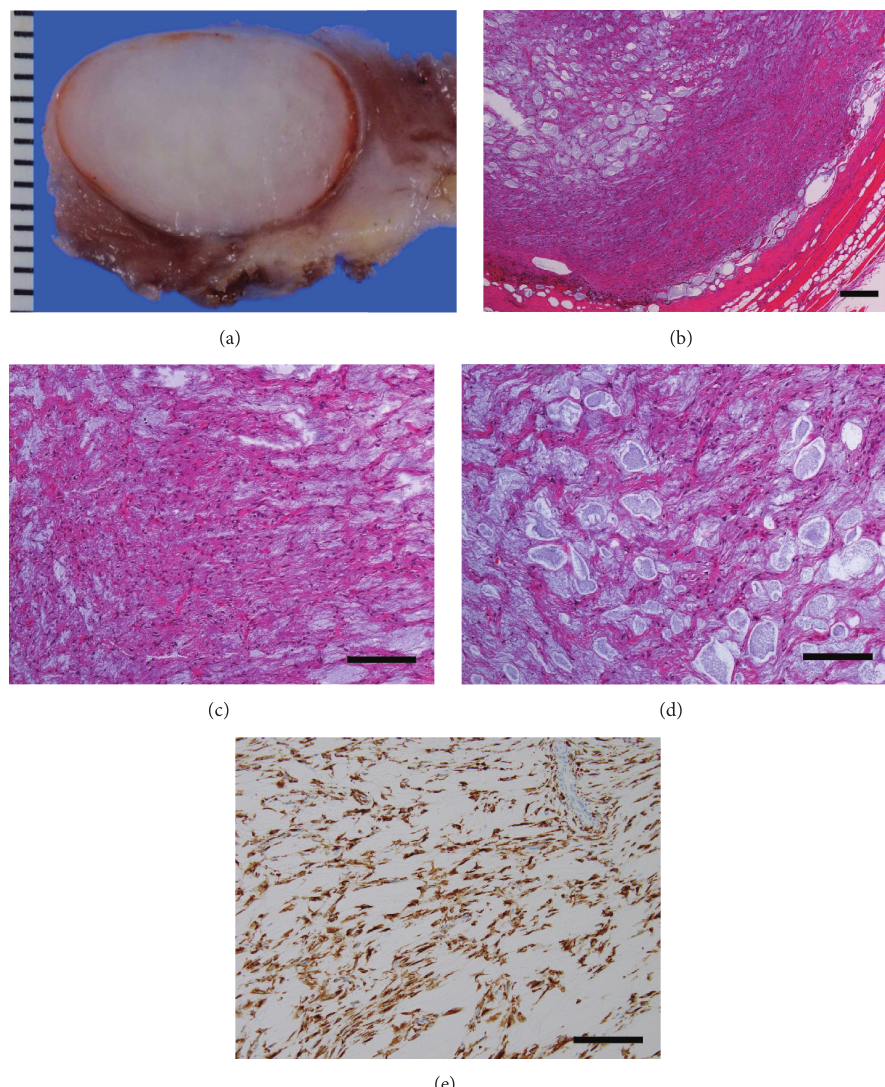
Figure 2: (a) The cut surface of the tumor revealed that the lesion was pale white and glistening in appearance. (b) A microscopic examination showed alternating areas with a fibrous and myxoid stroma. Scale bar is 500 𝜇 m. (c) Low-power view of the myxoid zone. Scale bar is 50 𝜇 m. (d) Low-power view of the fibrous zone. Scale bar is 50 𝜇 m. (e) The tumor shows diffuse cytoplasmic expression of MUC4, characteristic of